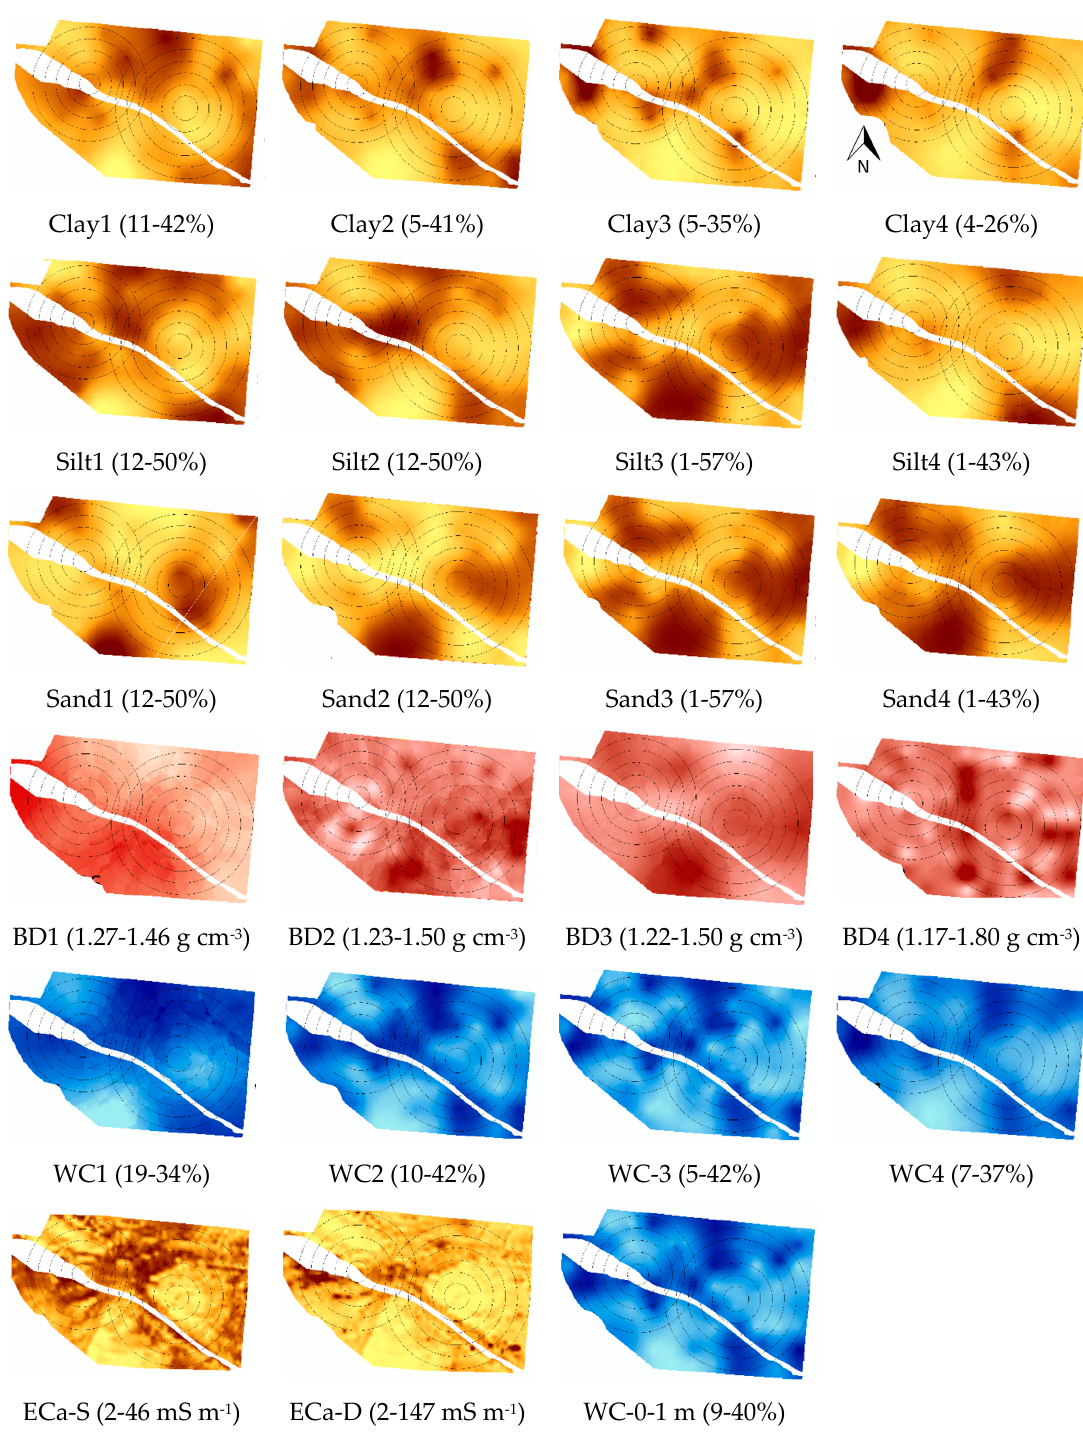
Figure 5. Maps of six different soil properties and their range of variation within a 73-ha two-pivot field in west Tennessee. These attributes include percent silt, sand, and clay, bulk density (BD, g cm − 3 ), volumetric water content (WC, %), and apparent electrical conductivity shallow (ECa-S, mS m − 1 ) and deep (ECa-D, mS m − 1 ). Numbers 1-4 denote layers 1–4 (layer 1: 0–25 cm, layer 2: 25–50 cm, layer 3: 50–75 cm, and layer 4: 75–100 cm). The maps were generated using ordinary kriging. The darker colors correspond to greater values for each attribute.